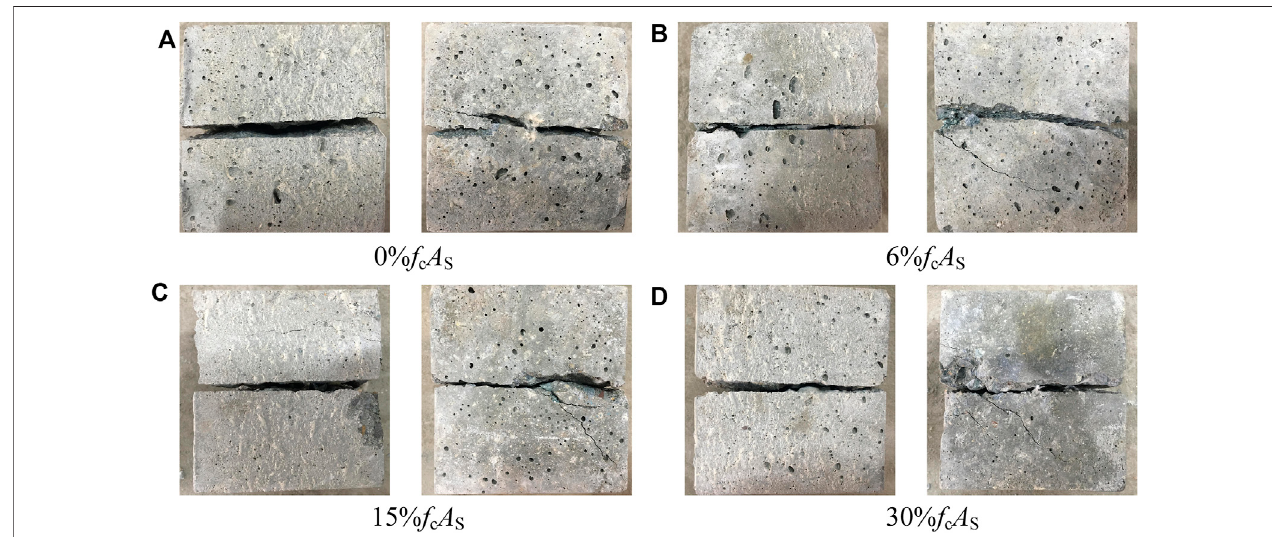
FIGURE 5 | Shear failure modes of SCC under different axial loads. (A) 0%fcAS. (B) 6%fcAS. (C) 15%fcAS. (D) 30%fcAS.